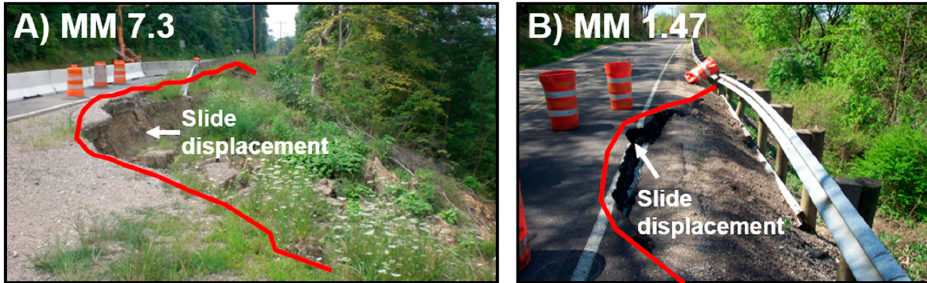
Figure 2. Examples of rotational slides affecting the embankment, near SR-666 Mile Marker (MM) 7.3 ( A ) and MM 1.47 ( B ). The landslide upper sections/scarps are outlined in red in both